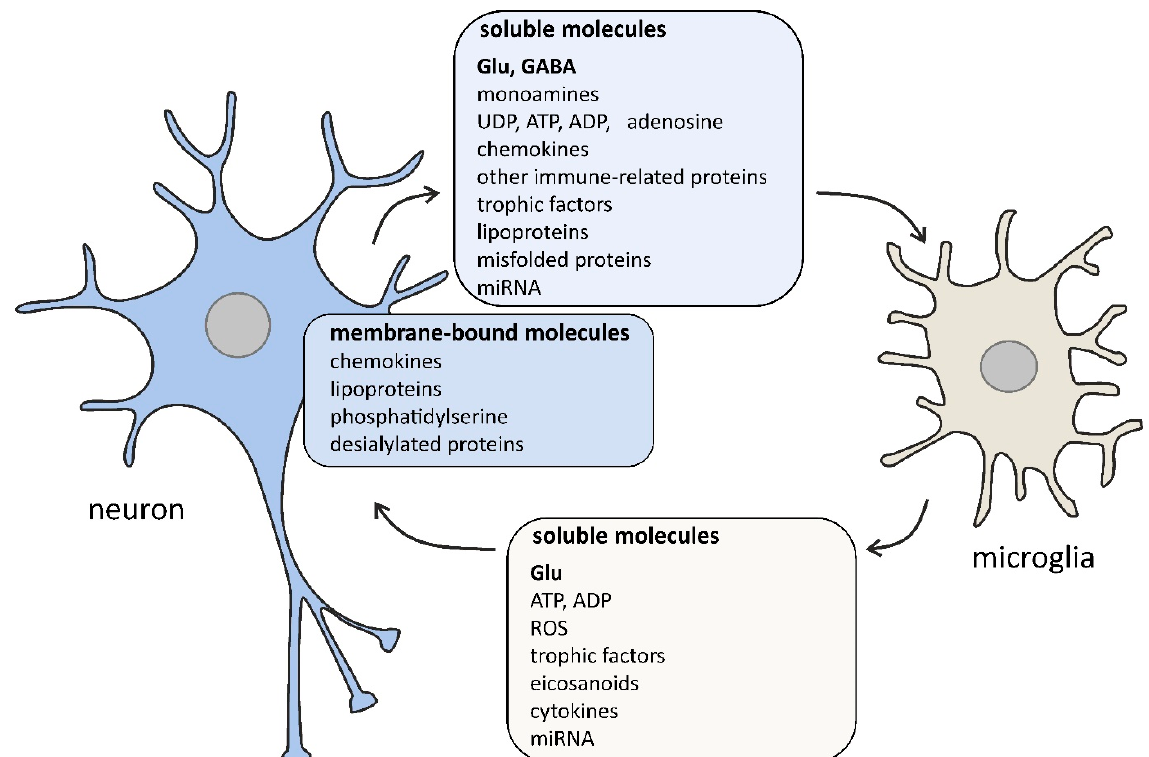
Figure 1. The selected signaling molecules, both cell surface-bound and soluble, that are involved in the cross-talk between neurons and microglia. The bidirectional communication between neurons and microglia is mediated by numerous molecules. Neurons affect microglial function by classical (glutamate, GABA, dopamine, serotonin, ATP) and non-classical neurotransmitters (UDP, ADP, adenosine), chemokines (membrane-bound and soluble CX3CL1), membrane-bound proteins (CD200, CD22, CD34, CD47), complement system components (C1q, C3), trophic factors (colony-stimulating factor-1, transforming growth factor β ), lipoproteins (apolipoprotein E), membrane-bound phosphatidylserine, desialylated membrane proteins, misfolded proteins (amyloid β , α -synuclein), and miRNA (e.g., miR-124 and miR-9). Microglia affect neurons by releasing gliotransmitters (glutamate, ATP, ADP), reactive oxygen species (ROS; e.g., nitric oxide, superoxide), eicosanoids (prostaglandin E 2 ), cytokines (interleukin 1 β , tumor necrosis factor α ), trophic factors (brain-derived neurotrophic factor), and miRNA (e.g., miR-146a). Some signaling pathways occur only under pathological conditions.